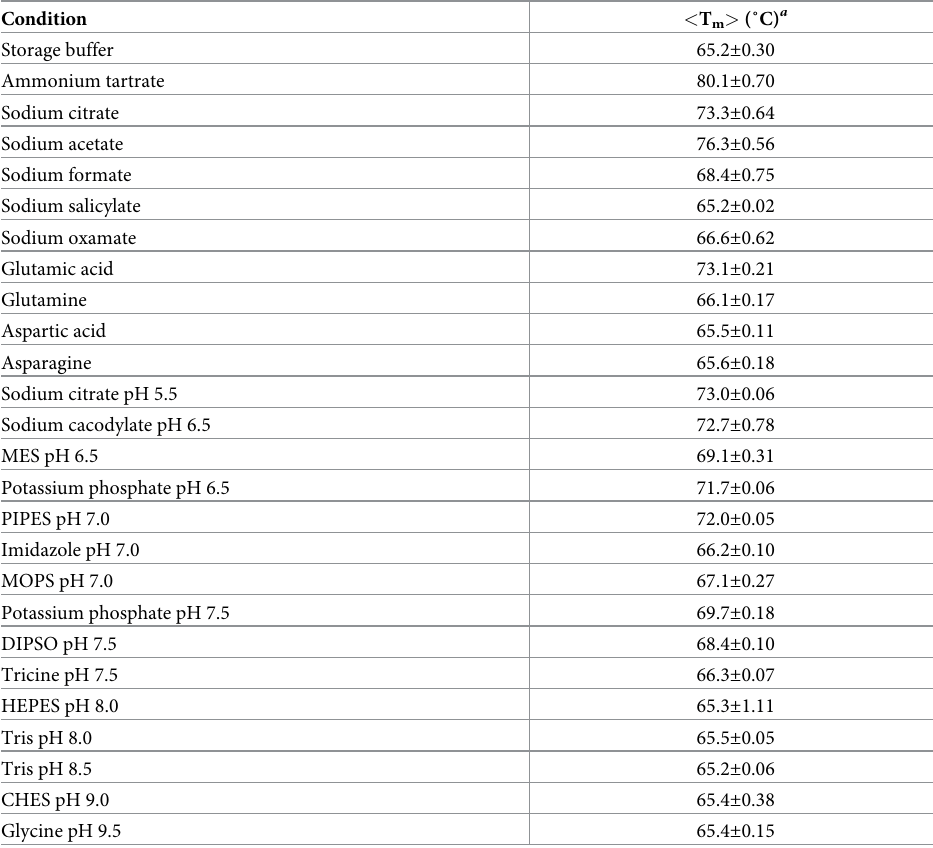
Table 2. Results of TSA